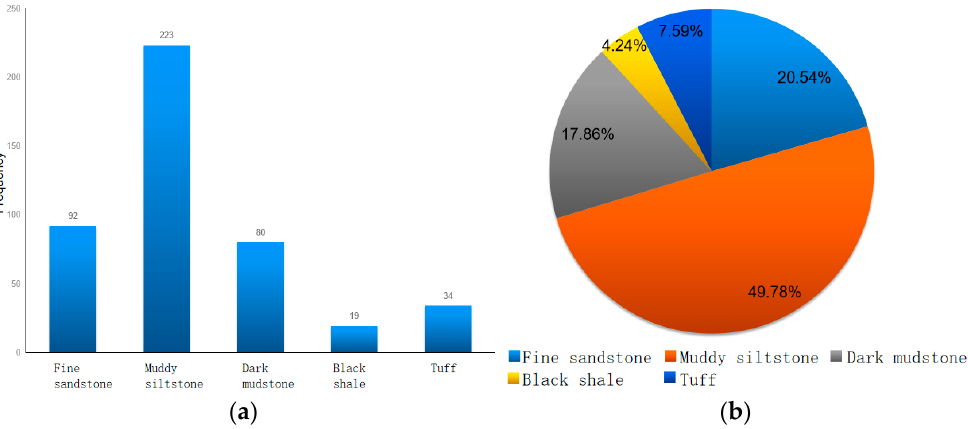
Figure 1. Statistical histogram and pie chart of the number of slices with di ff erent lithologies. ( a ) Histogram of the number of lithologic slices; ( b ) Statistical pie chart of lithology slice quantity.